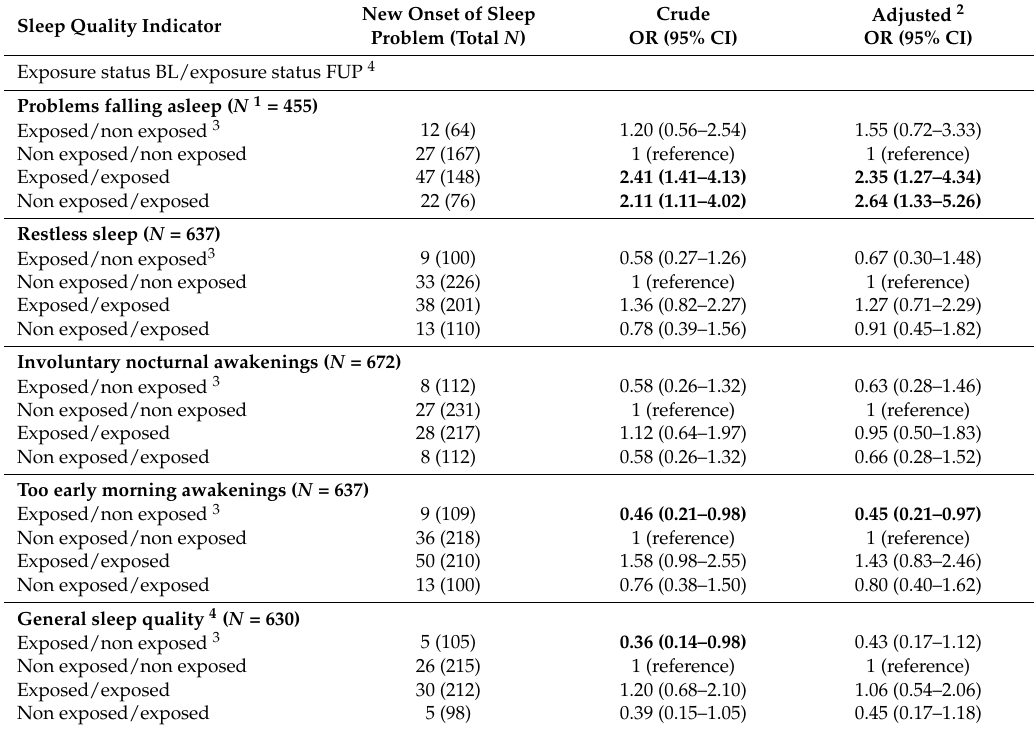
Table 4. OR to develop impaired sleep quality between BL and FUP in relation to total screen time. Significant associations are displayed in